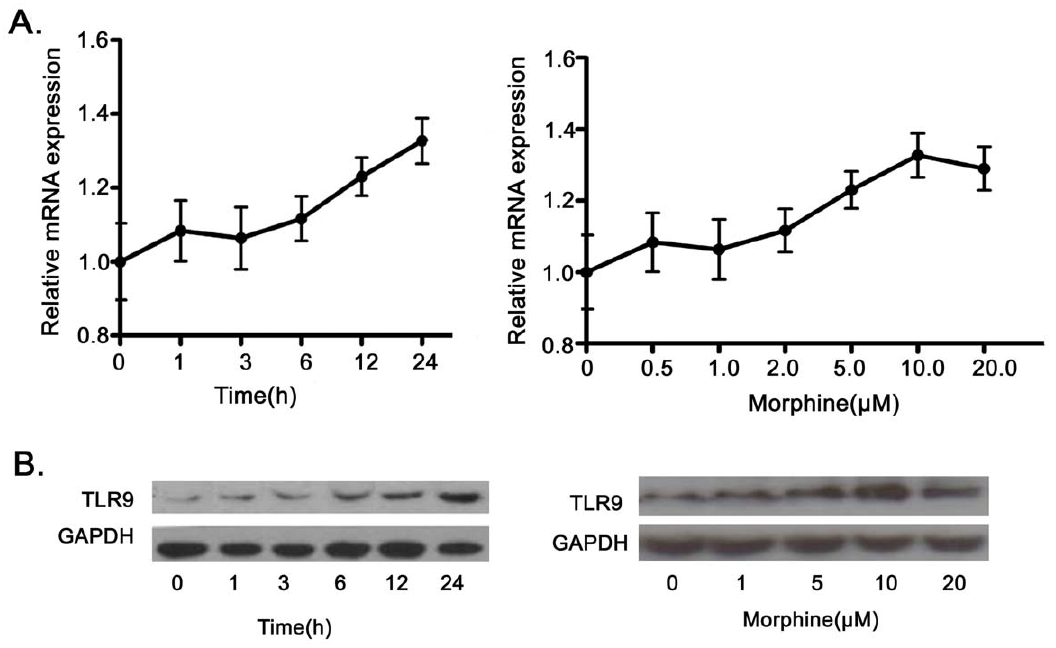
Figure 1. Morphine induces TLR9 expression in a dose and time dependent manner in wild type microglia. (A). Morphine induces the expression of TLR9 in mRNA level in a dose and time dependent. Mouse primary microglial cells were treated with 10 m M morphine for various time periods or different concentrations of morphine for 12 hr, respectively. The expression of TLR9 was determined by quantitative real time RT-PCR as described under Materials and Methods. Results represent mean 6 SD of three independent experiments. (B). TLR9 expression in protein levels were determined by western blot. Cells were treated with 10 m M morphine for various time or various concentrations of morphine for 24 hr, respectively. Data are representative of three independent experiments.